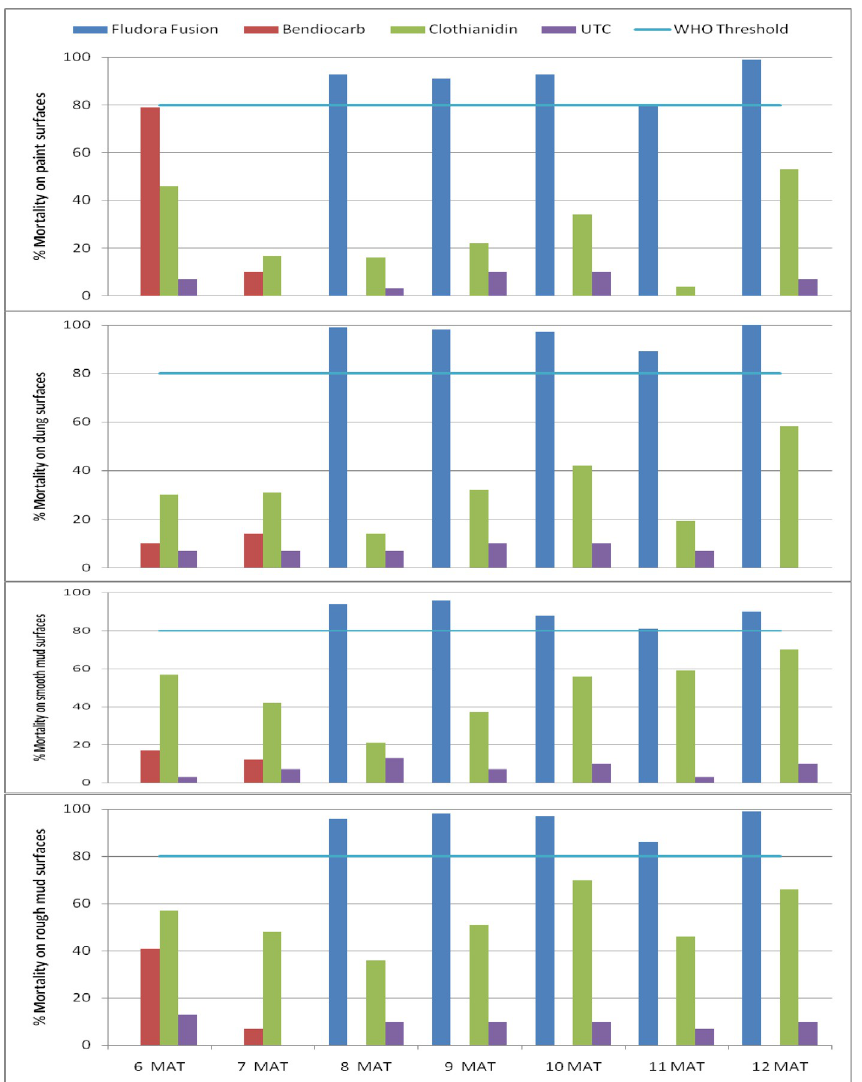
Fig 4. Residual activity of insecticides against susceptible Anopheles arabiensis on four surface types of simple huts wall cone bioassays at 72 hours holding time post-exposure, Ethiopia. against wild pyrethroid resistant An . gambiae s.l. [18]. In Equatorial Guinea, it caused over 80% residual efficacy, on wooden surfaces, against malaria transmitting wild pyrethroid resis- tant Anopheles mosquitoes for a period of 8 months [19]. The very high and prolonged knock- down and efficacy of Fludora Fusion against the laboratory reared An . arabiensis warrant its potential use in IRS programs in Ethiopia. In addition, its residual insecticidal effect against of choice for IRS programs in view of the widespread insecticide resistance. malaria vectors might be attributed to their synergistic activity when combined. As a mixture product it assures contact by the mosquito to two active ingredients at the same time [16]. Therefore, the mosquito needs to detoxify both regardless if they are pyrethroid resistant or not. Clothianidin is a molecule that belongs to the chemical class of the neonicotinoids, so it